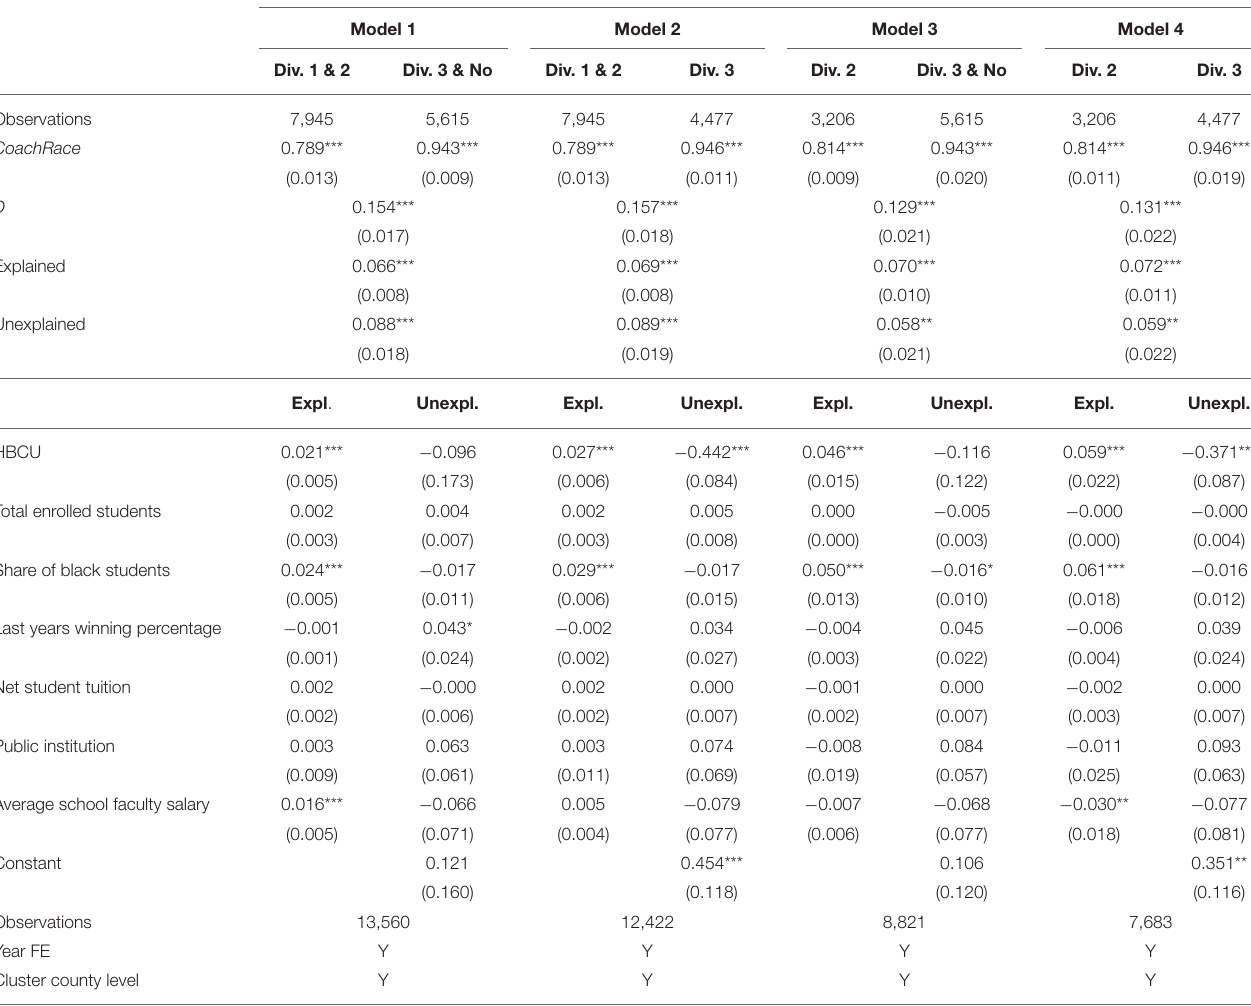
TABLE 5 | Model Results (Logit).